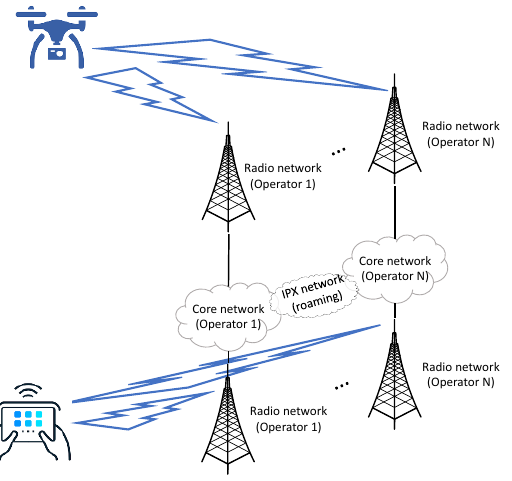
Figure 2. Connectivity scenario of two links: Unmanned aerial vehicles (UAV) to antenna and antenna to Control station. N network operators.